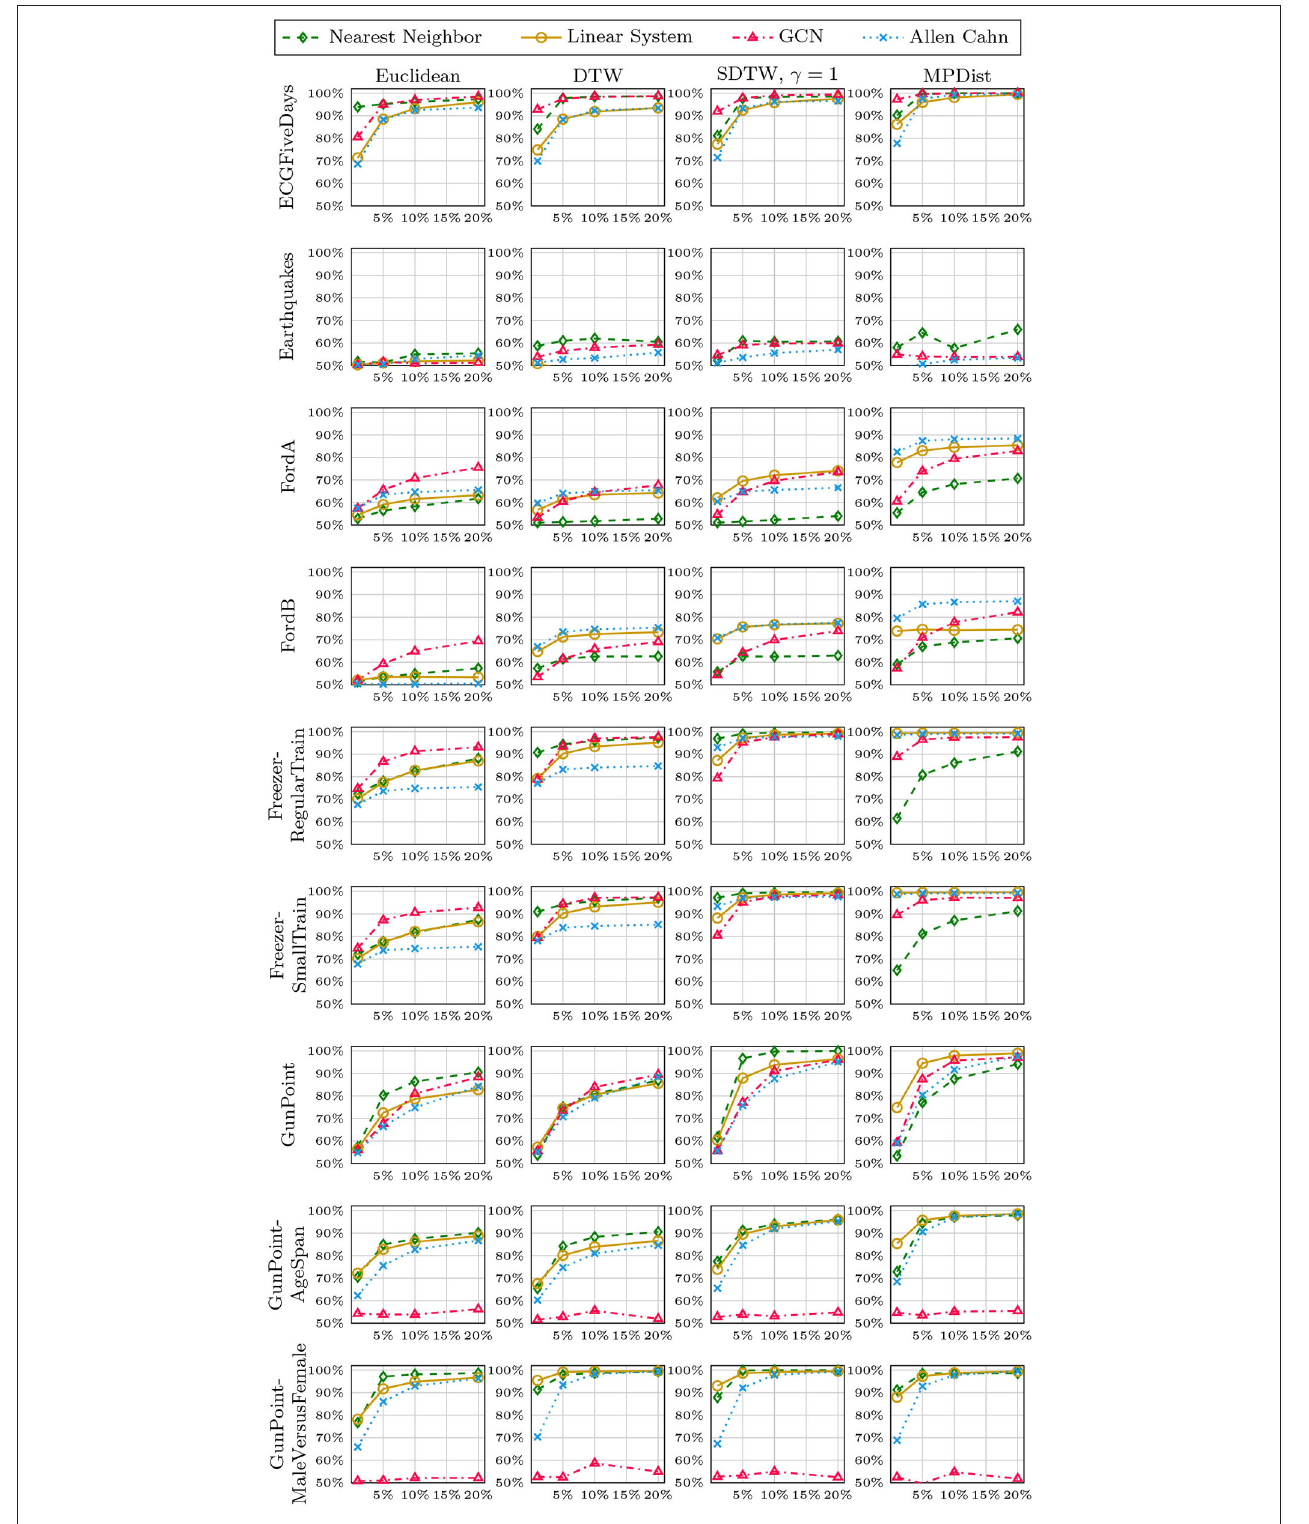
FIGURE 9 | Method accuracy comparison for random training splits of different sizes (part